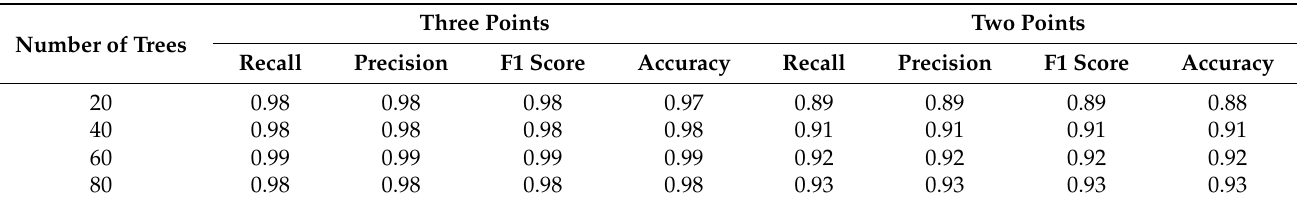
Table 4. Experiment with random forest method.